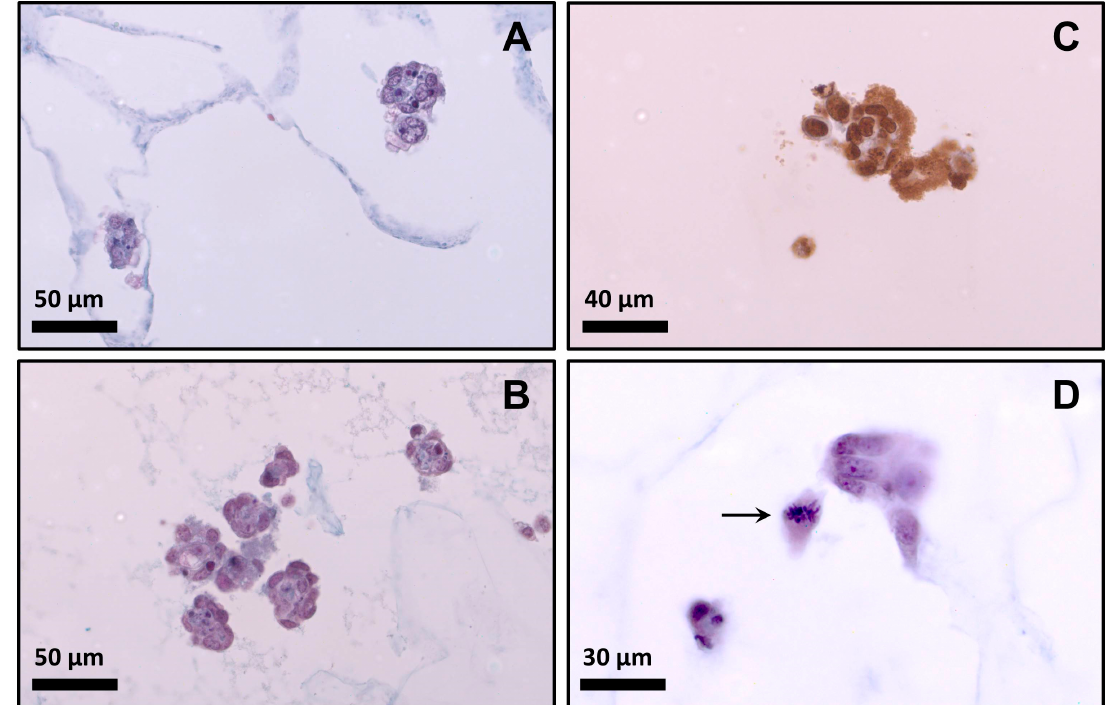
Figure 8. Behavior of myoblasts inside the scaffold after 48 h of seeding. ( A ) Photomicrograph of scaffold Ag (histochemical technique); ( B ) Photomicrograph of scaffold Bg (histochemical technique); ( C ) Cells seeded on scaffold Bg showing positive immunostaining for BrdU (immuno histochemical technique); ( D ) Photomicrograph of scaffold Bg (arrowed cell in metaphase).